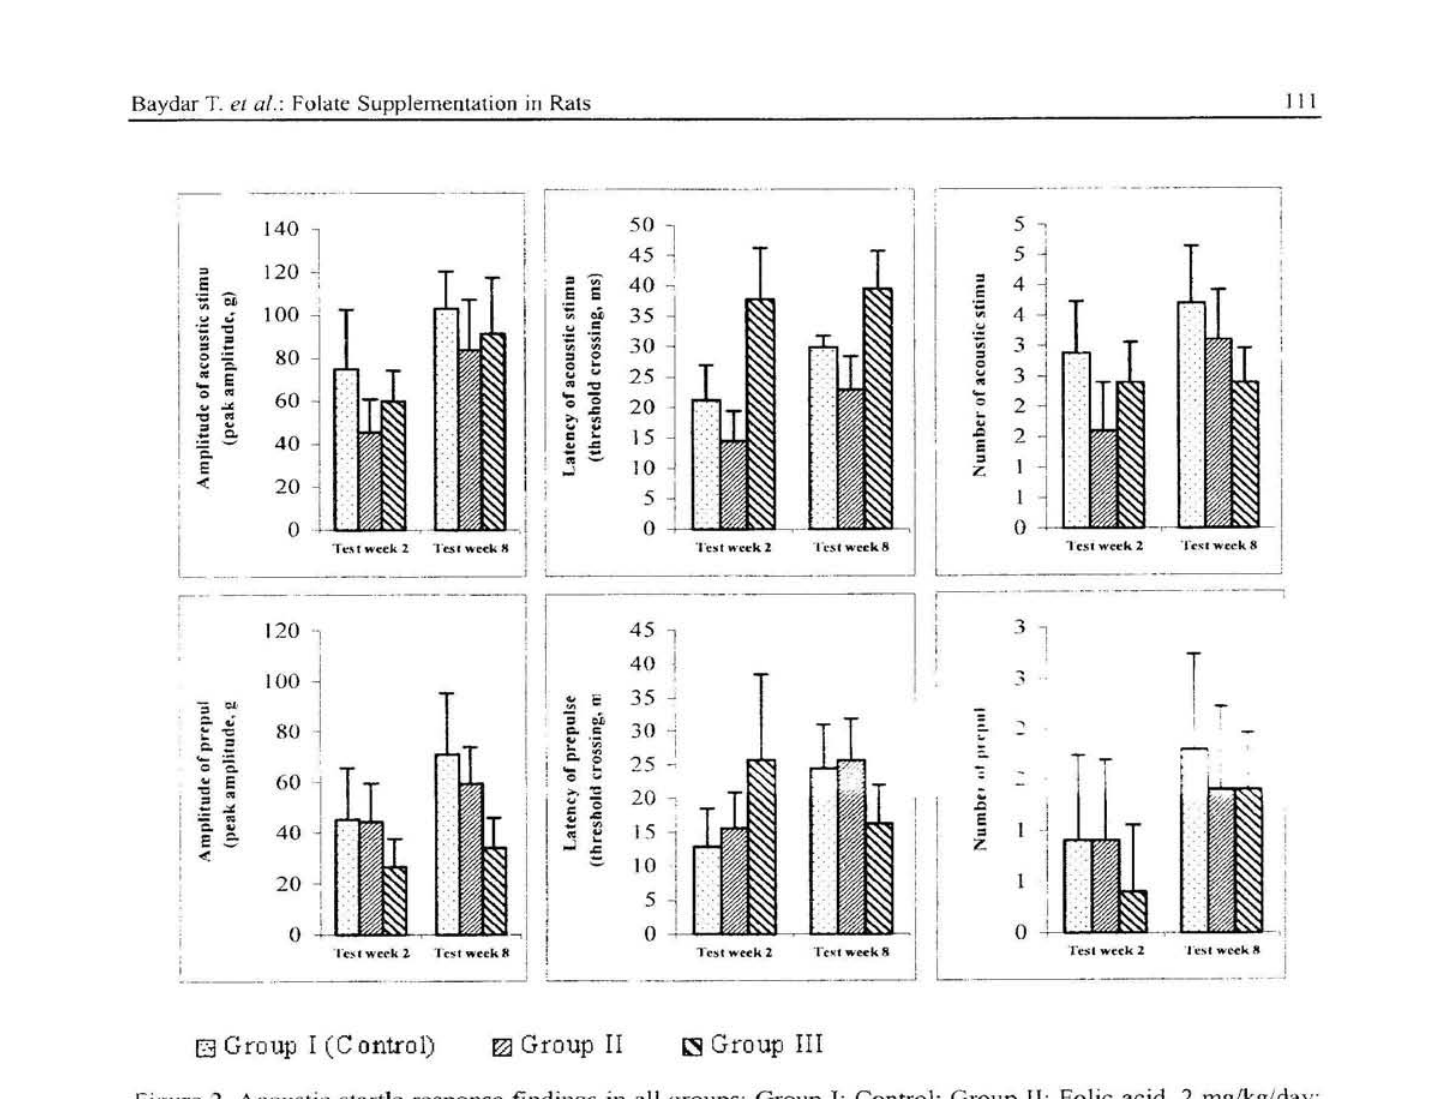
Figure 2. Acoustic startle response findings in all groups; Group I: Control; Group II: Folic acid, 2 mg/kg/day; Group III: Folic acid, 20 mg/kg/day. (Data are presented as means ± SEM, n=10; there were no statistical differ- ences between various groups, p>0.05)